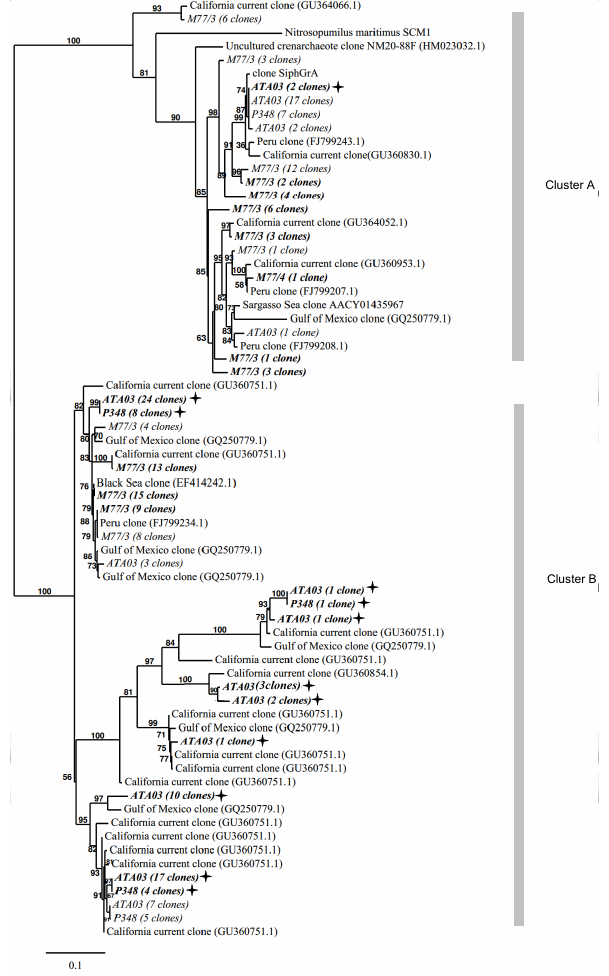
Fig. 5. Distance-based neighbour-joining phylogenetic tree of ar- chaeal amoA sequences from the ETNA (cruises ATA03 and P348) and ETSP (cruise M77/3). Sequences derived from the oxygen min- imum zone (OMZ) of the ETNA are in italics, bold and marked with solid stars; sequences from above the OMZ are in italics. Sequences from the OMZ of the ETSP are in italics and bold; sequences from above the OMZ are in